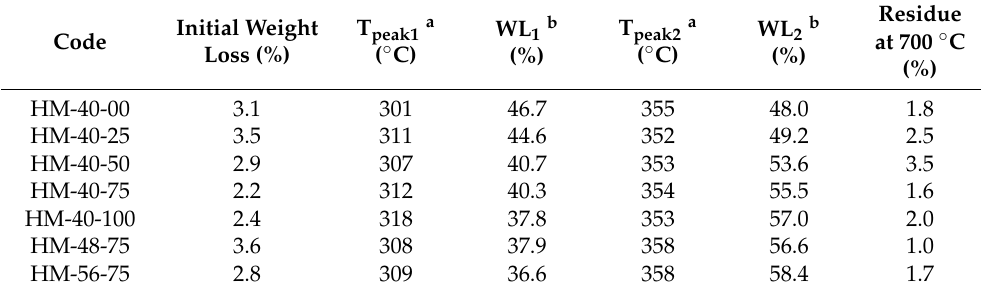
Table 2. Summary of high resolution TGA data.